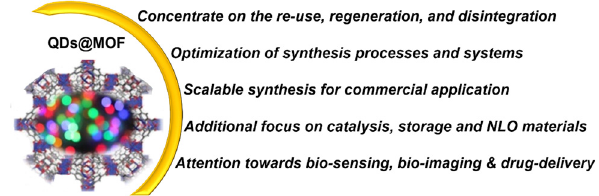
Figure 14: QDs@MOF: challenges and